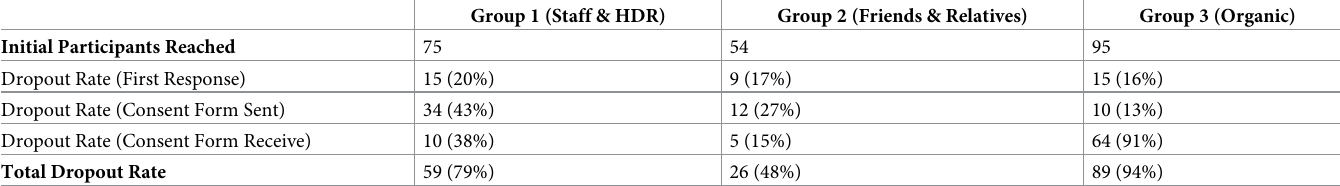
Table 8. Participants dropout